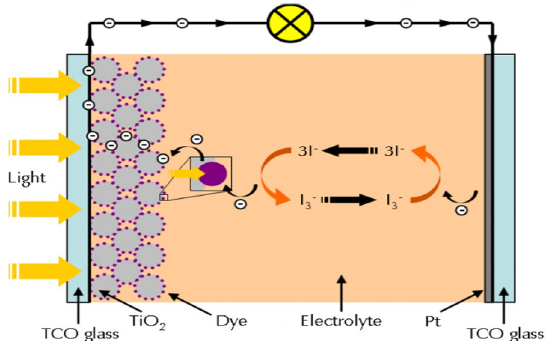
Fig. 6 Dye-sensitized solar cell (Serrano et al.